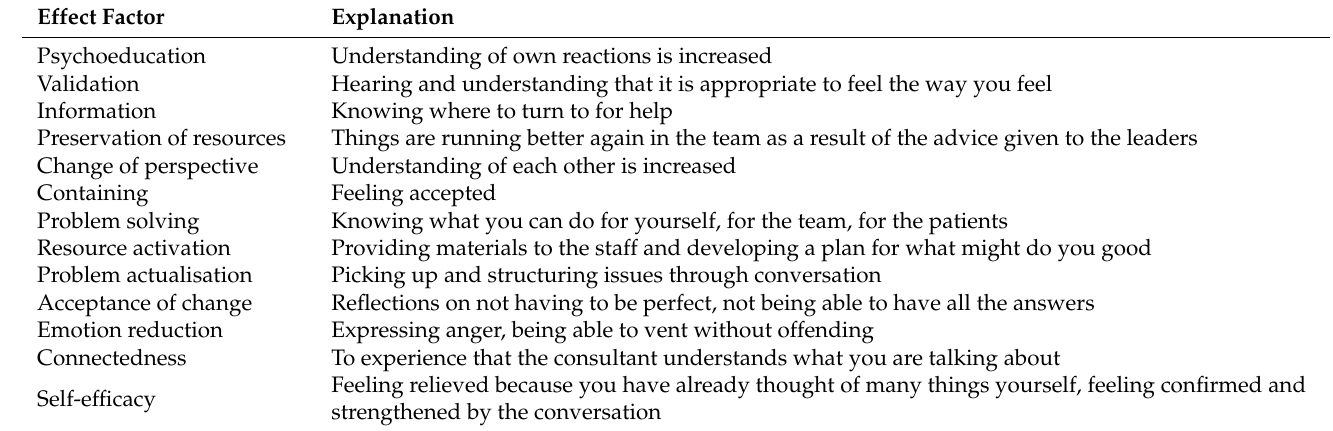
Table 2. Identified effect factors and their